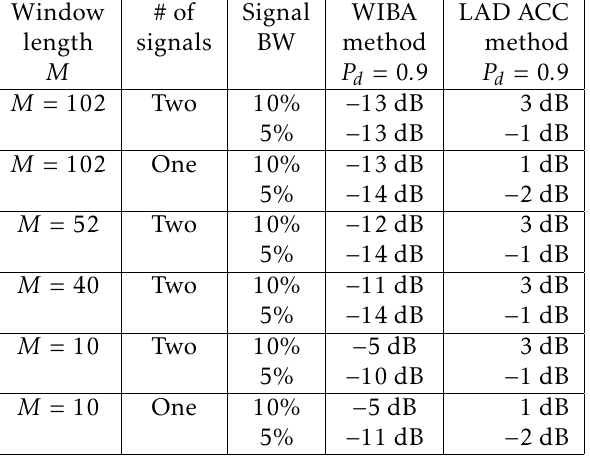
Table 5. Required SNR [dB] for P two signals present.